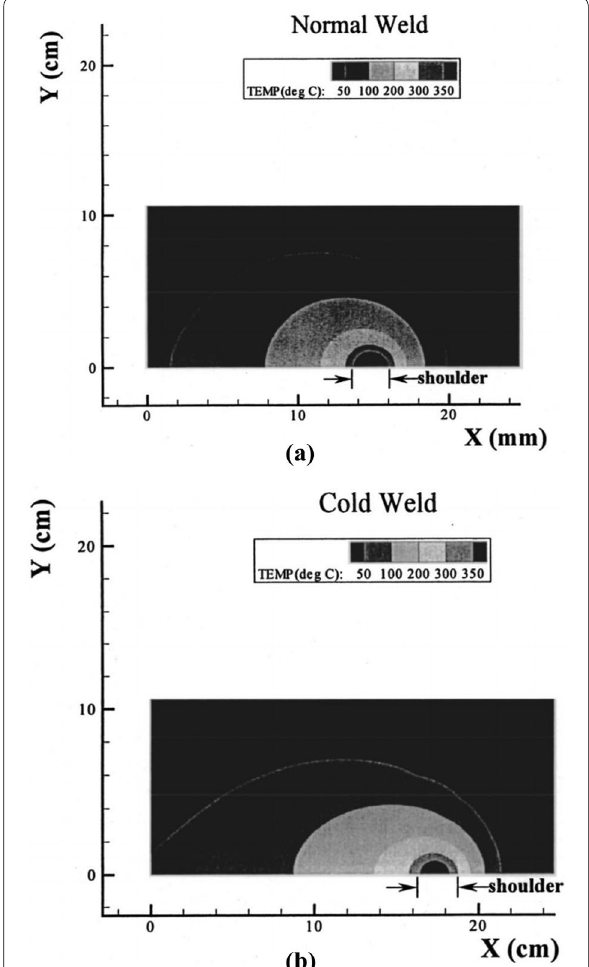
Figure 14 Distribution of the temperature: ( a ) the normal welding condition and ( b ) the cold welding conditions